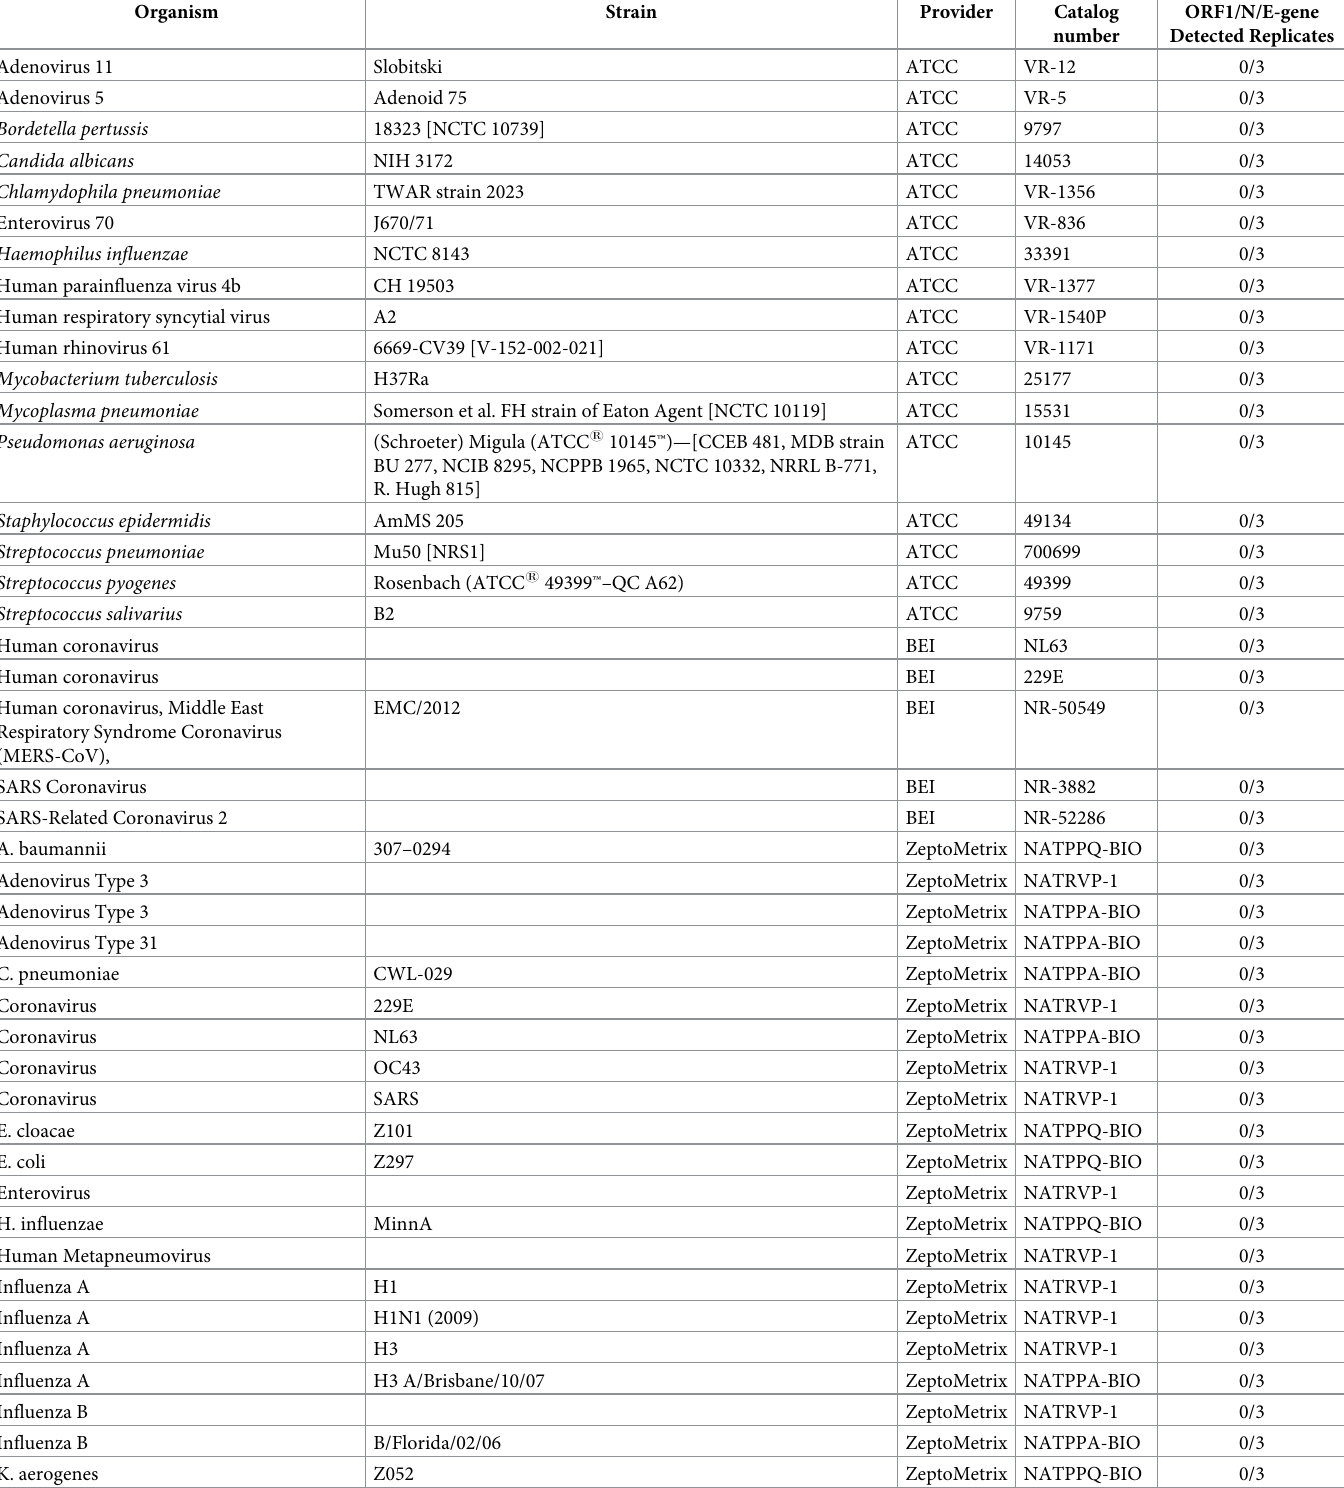
Table 5. Cross-reactivity/exclusivity wet testing of the Prime CovidDetect ™ rapid detection